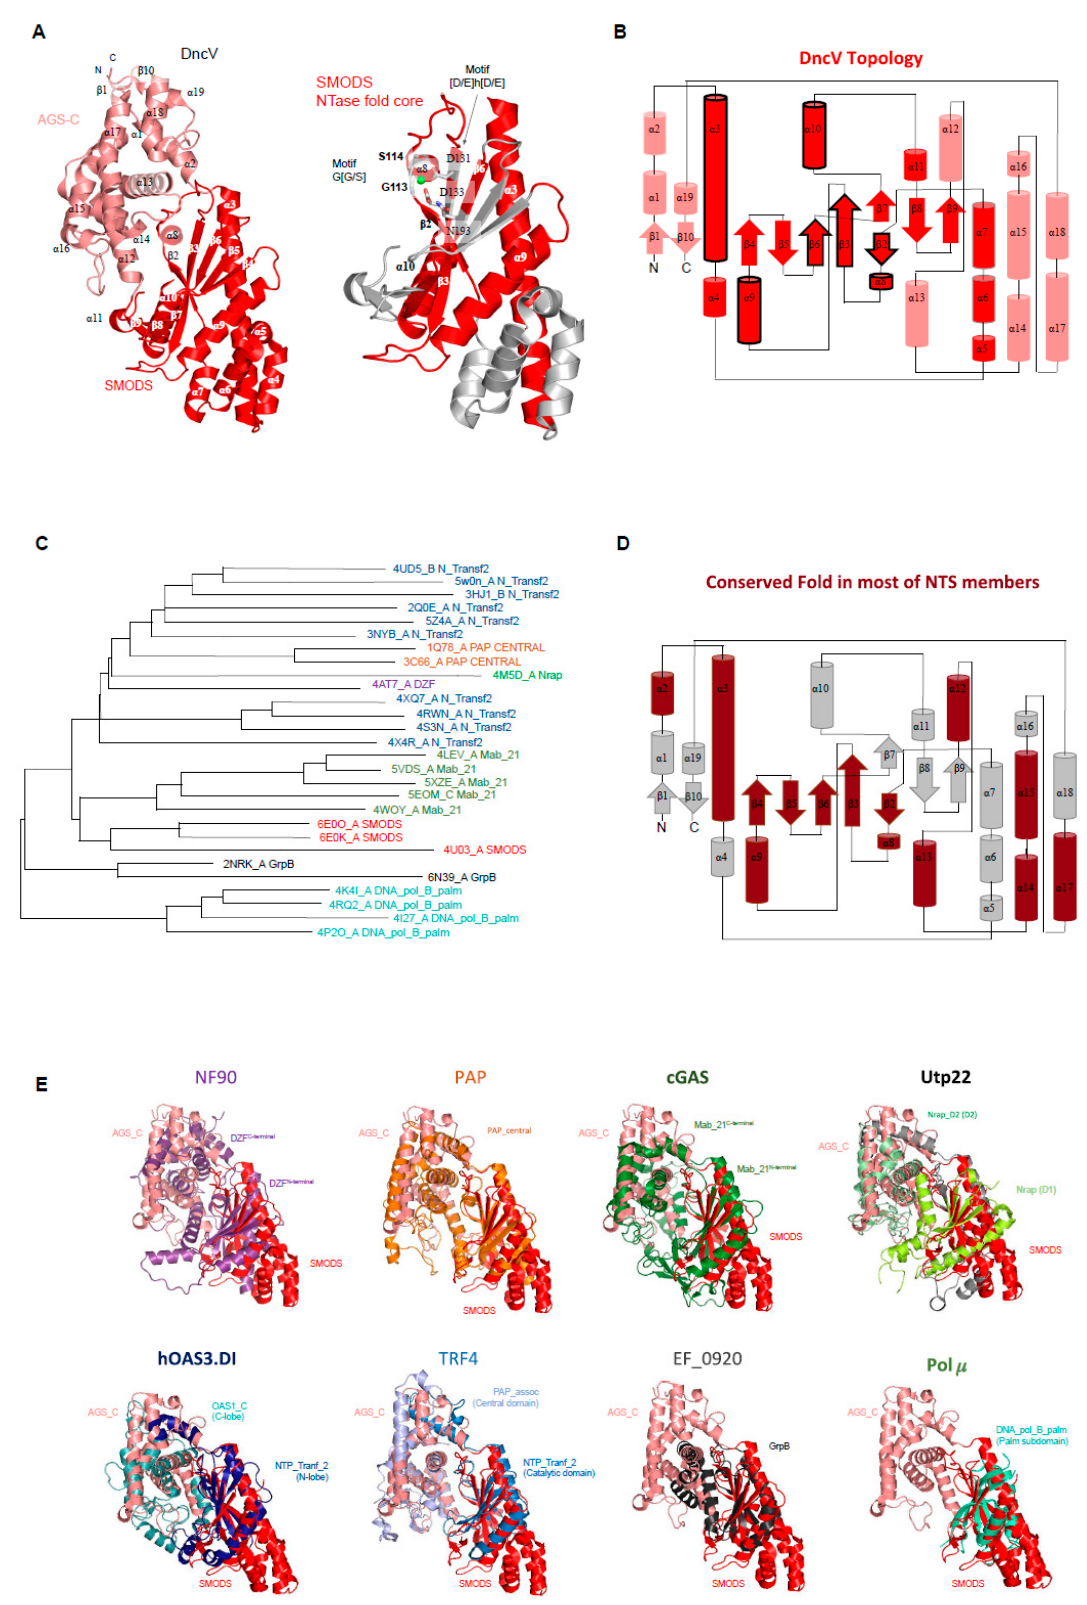
Figure 4. Structural similarities between the SMODS domain and other nucleotidyltransferase superfamily members. ( A ) the N-terminal domain SMODS (colored in red) and the C-terminal ACS_C (light pink) of the DncV protein structure are shown as cartoons (PDBID: 4U0M). The SMODS domain